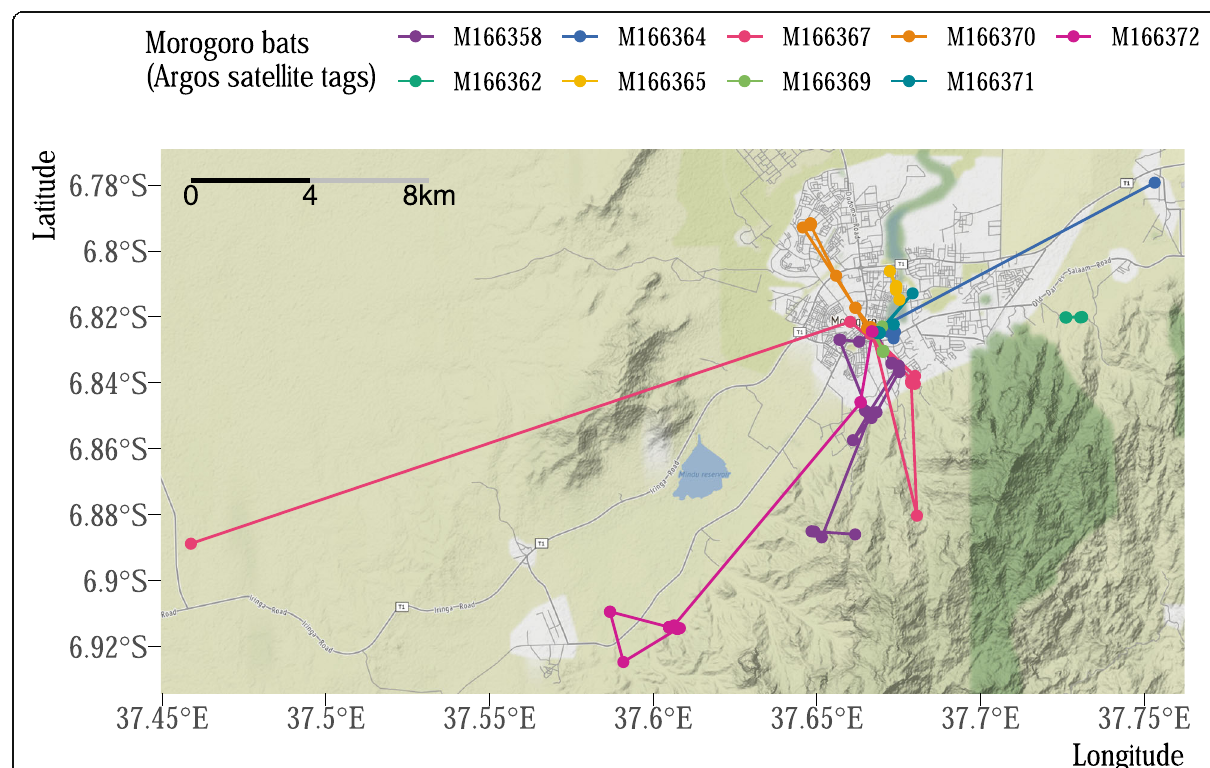
Fig. 3 Map of the tracking data obtained from nine of the ten bats tagged with Argos satellite tags in Morogoro